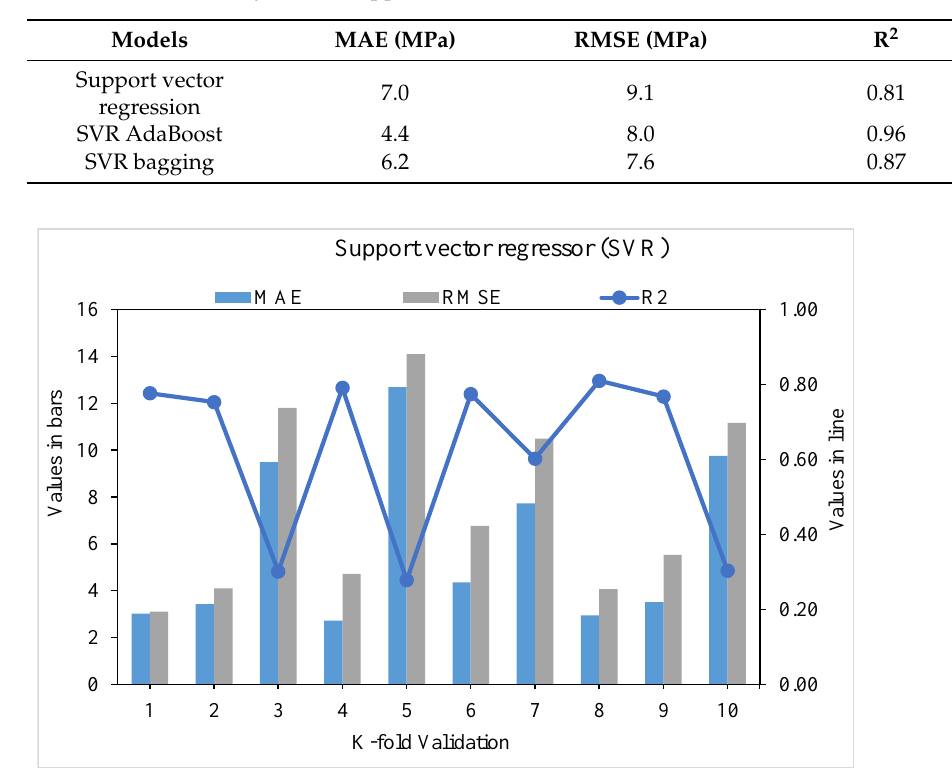
Figure 9. Support vector regression model with K-fold cross-validation representation.